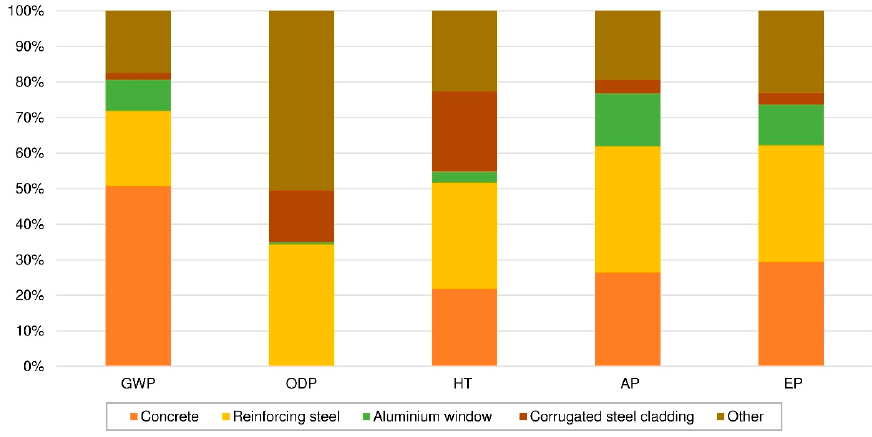
Figure 2. Total environmental impacts for modules A1–A4 by construction materials used in the school building. (The group of “Other” includes paint, plywood board, underroof membrane, glulam, stone wool, HDPE, plaster, EPS, and XPS.) Table 5. Total environmental impacts from concrete and stone wool produced in Iceland.